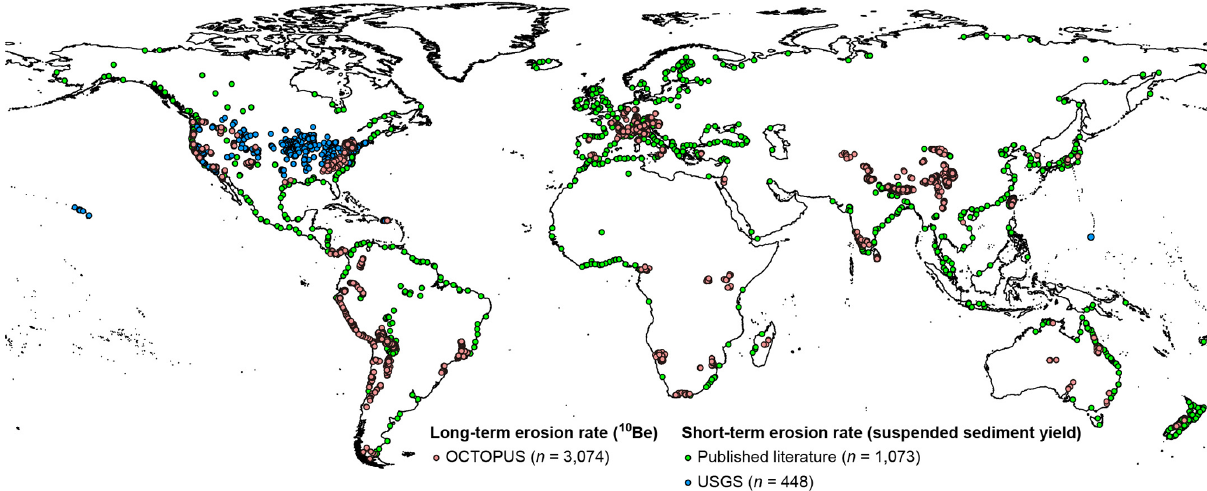
Figure 1. Global map of drainage basin erosion rate locations. Long-term erosion rates were obtained from OCTOPUS (Open Cosmogenic Isotope and Luminescence, red), estimated by 10 Be in the fluvial sediments. Short-term erosion rates were compiled from published literature (green) and USGS data (blue), determined by suspended sediment yield of gauging stations. The coastline is from Natural Earth (https: //www.naturalearthdata.com/, last access: 19 May 2018) in the Pseudo Plate Carrée map